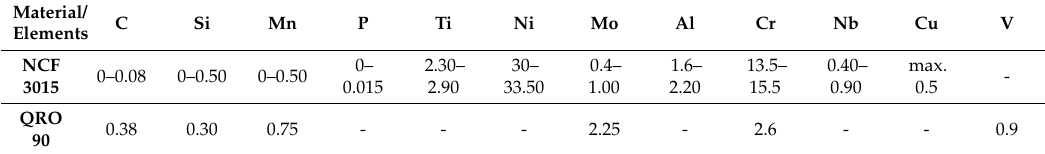
Table 1. The chemical composition of input material (NCF3015) and material of forging dies (QRO 90) (%). Material/Elements